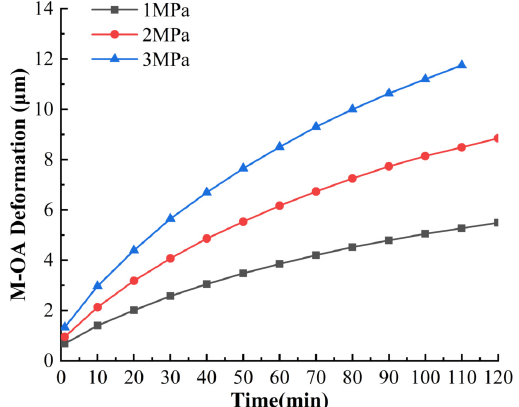
Figure12. ThermaldeformationsofthevalveorificecalculatedwiththeM-OAmethodwith P in = 1 MPa, Figure 12. Thermal deformations of the valve orifice calculated with the M-OA method with P in = 1 MPa, 2 MPa and 3 2 MPa and 3 MPa.